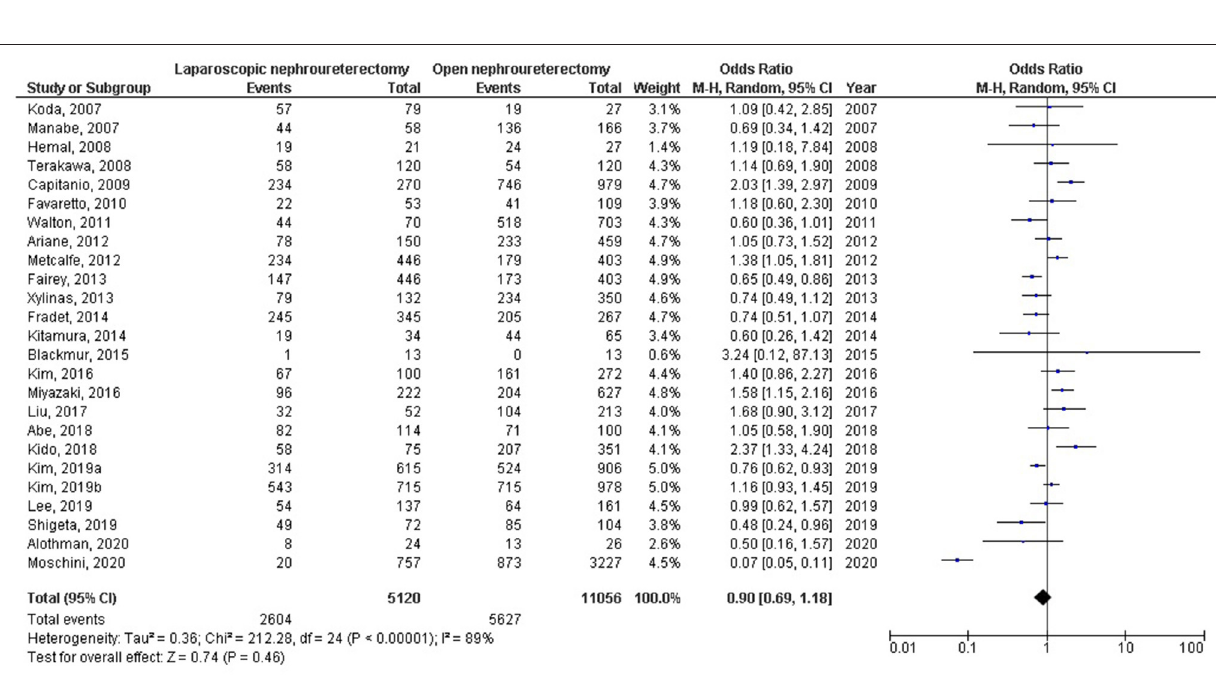
Frontiers in Surgery |